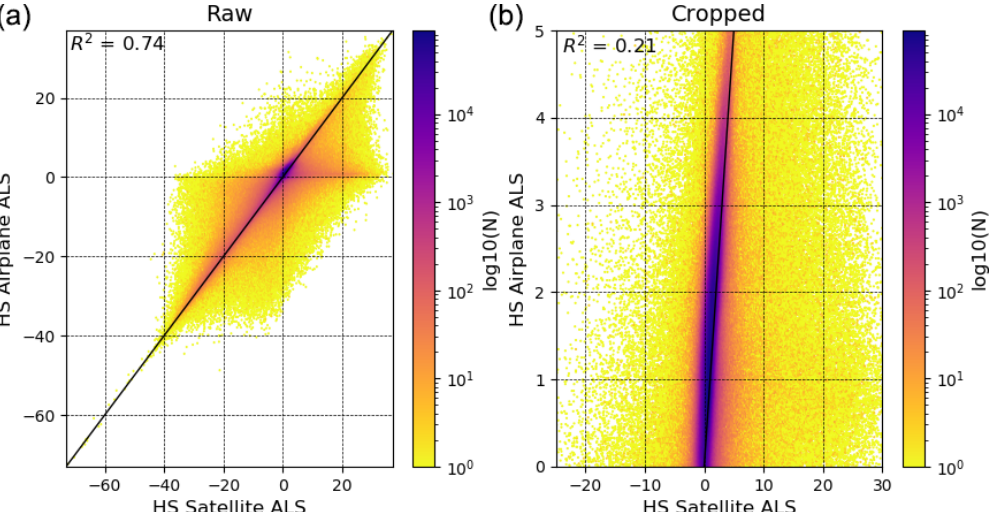
Figure 12. Scatter plot for comparison 3, where satellite snow depth is compared to the airplane snow depth. The left scatter plot shows all data. The right scatter plot shows only the snow depth estimates where the airplane snow depth is between 0 and 5m. This cropping removed 21.27% of the data. The scatter plots have a logarithmic scale, which is shown on the right side with a plasma colour bar. R 2 is given for each scatter